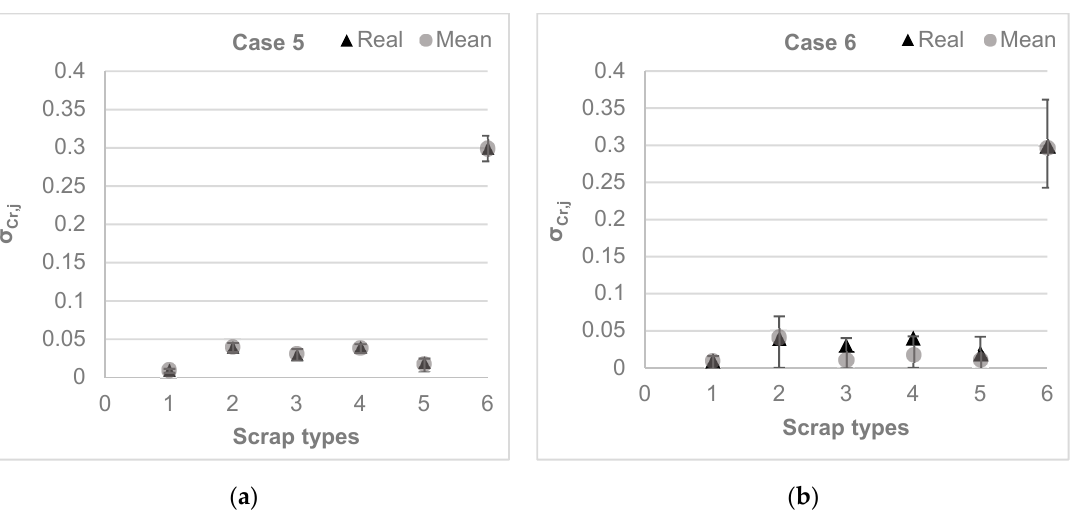
Figure 2. Estimated mean standard deviations for concentration of Cu ( (cid:2026) (cid:3364) (cid:1829)(cid:1873) ) with a 95% confidence interval in scrap types, x1–x6 for cases 1–4, ( a – d ).